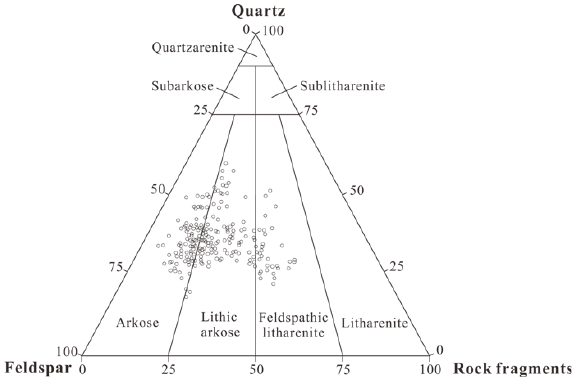
Figure 2. Triangular classification of the Chang 9 sandstones using Folk’s classification.